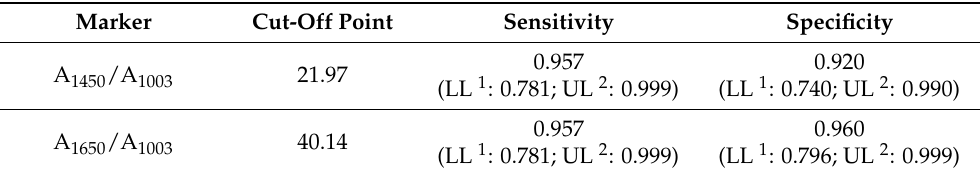
Table 4. Optimal cut-off points obtained following the Youden method, sensitivity, and specificity (values, lower and upper limits at 95% confidence interval), related to A 1450 /A 1003 and A 1650 /A 1003 ratios. Marker Cut-Off Point Sensitivity Specificity 0.957 A 1450 /A 1003 21.97 (LL 1 : 0.781; UL 2 : 0.999)